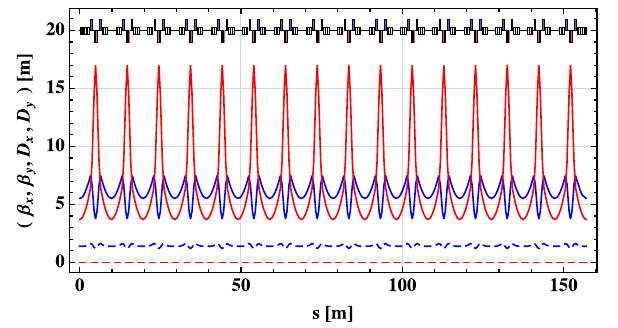
FIG. 1. PS Booster lattice and optics at injection. The β - function is indicated with a solid line and the dispersion with a dashed line. The horizontal plane is shown in blue and the vertical plane in